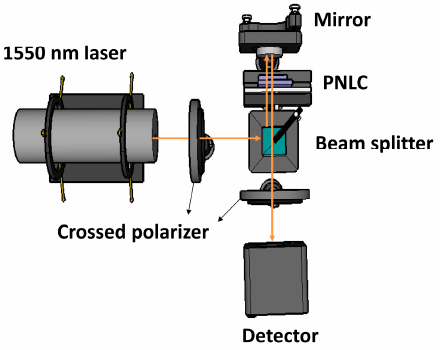
Figure 2. Experimental setup for measuring the V-R curves of completed PNLC cells. The rubbing direction of the cell is 45° with respect to the polarization direction of the crossed polarizers.